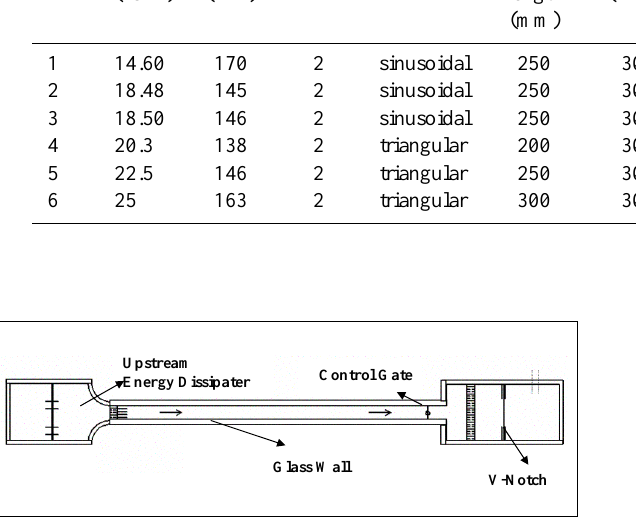
Figure 1- A schematic plan of experimental setup Fig. 1. A schematic plan of experimental setup.